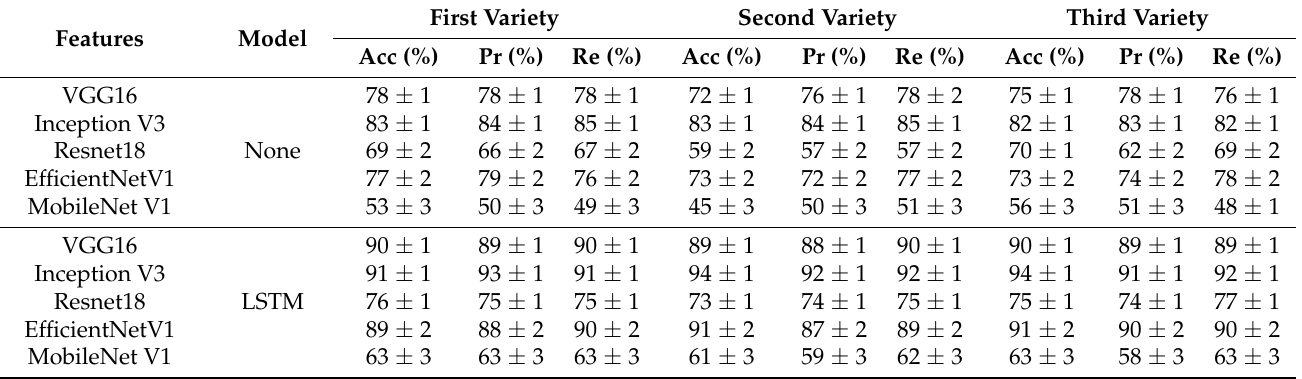
Table 5. Prediction accuracy of CNN and CNN-LSTM of 3-levels